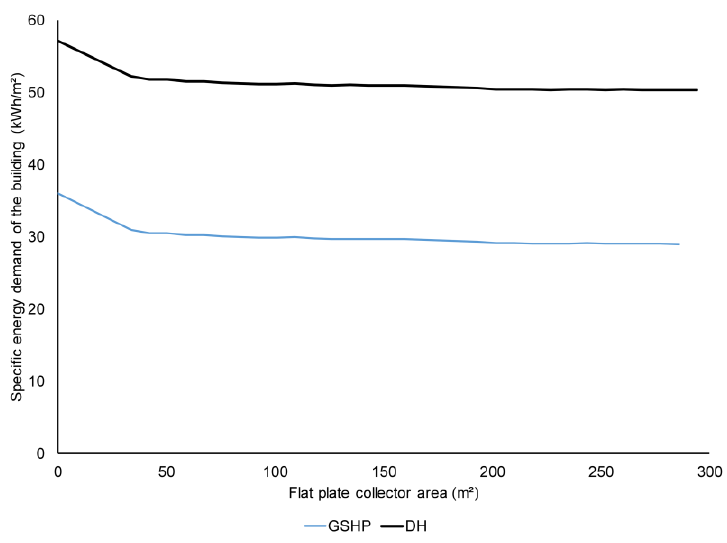
Figure 7. Specific energy demand for the building equipped with GSHP and DH as a function of installed flat-plate collector area.